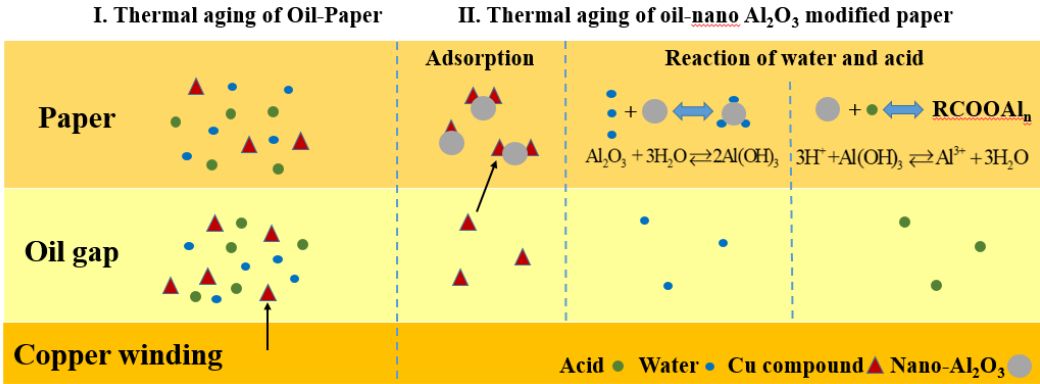
Figure 11. Influence of nano-Al 2 O 3 on thermal aging of insulating paper and oil .